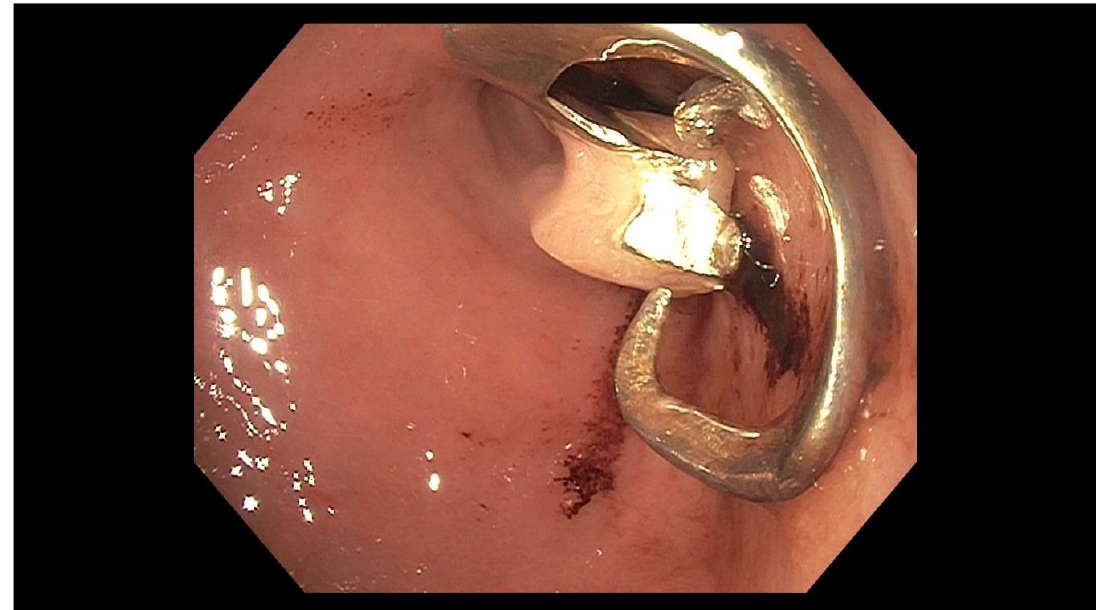
Figure 4. Foreign body hood protector in the mid-esophagus.